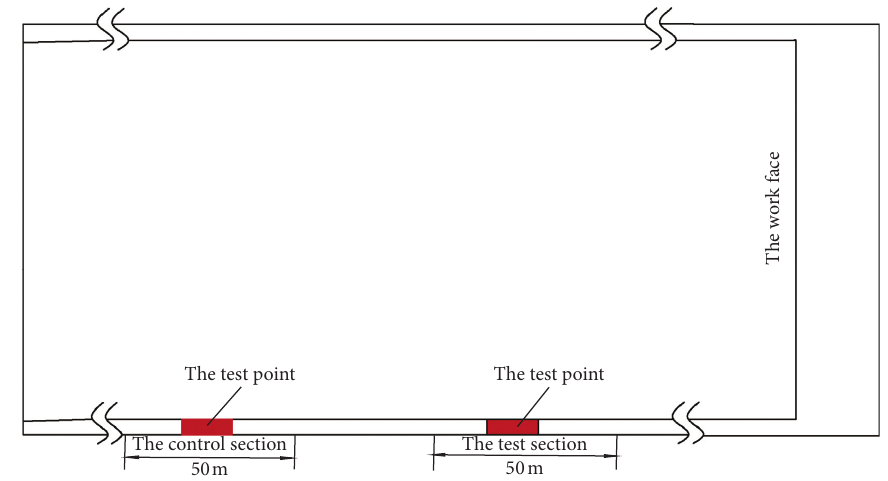
Figure 11: Layout of roadway test position and control